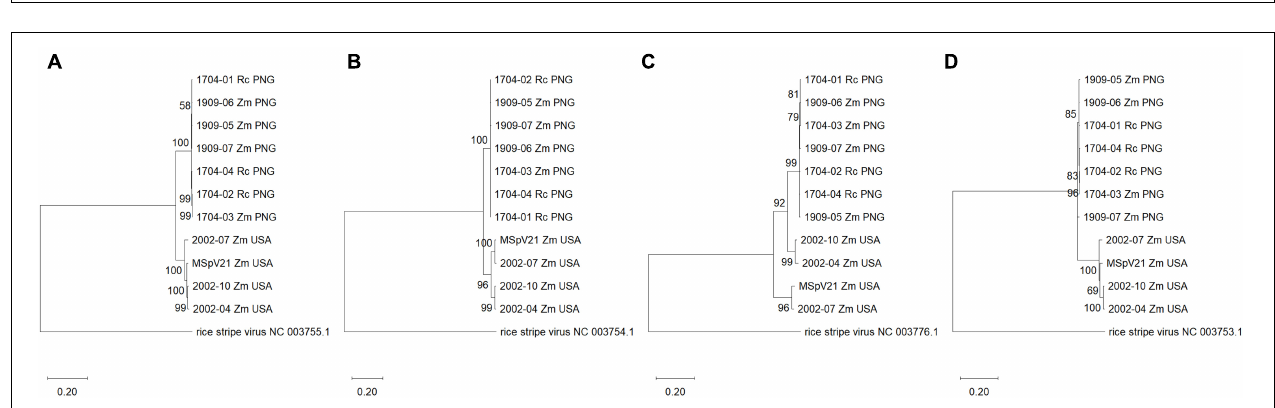
FIGURE 3 | (A) Maximum likelihood phylogenetic tree based on RNA-dependent RNA polymerase amino acid sequences from selected tenuiviruses and tenui-like viruses. Rift Valley fever virus, a phlebovirus, was selected as an outgroup. (B) Maximum likelihood phylogenetic tree of RNA3 for maize stripe virus isolates. RNA 3 from rice stripe virus was included as an outgroup. The National Center for Biotechnology Information accession and reference sequence numbers are provided to the right of the appropriate names. The numbers at the nodes are bootstrap values, and the scale bar represents the number of substitutions per site. Rc, Rottboellia cochinchinensis ; Zm, Zea mays ; Sb, Sorghum bicolor ; PNG, Papua New Guinea; USA, United States of America; I, India; F, France.